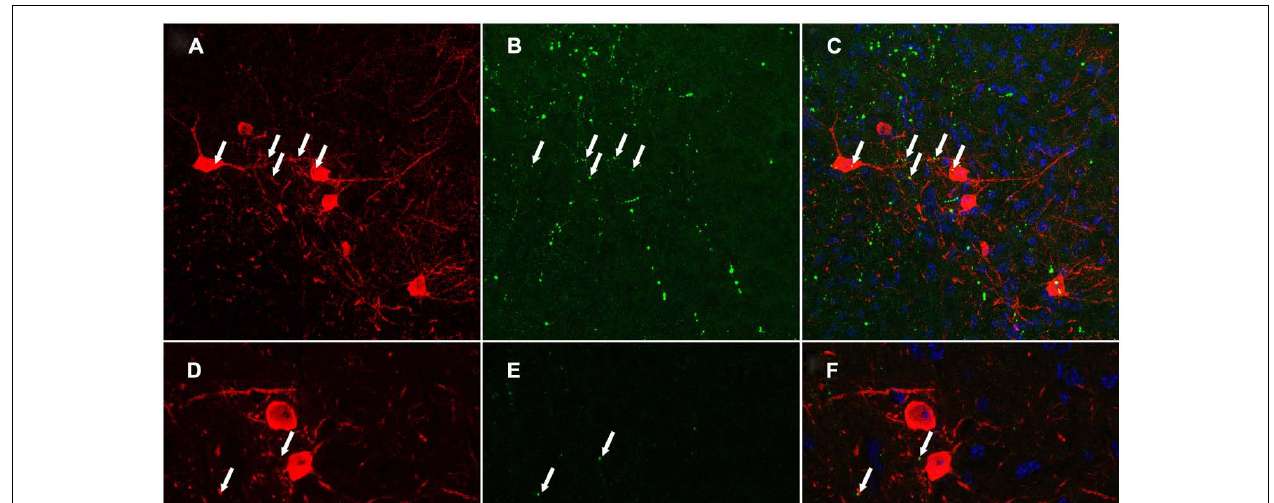
corticospinal terminations are found on motor neuron cell bodies, while sparse EGFP + puncta are detected on ChAT + presumptive dendrites (arrows). Note larger size of some EGFP + dots likely due to tyramide mediated signal amplification. Scale bar: (A – C) 75 μ m; (D – F) 30 μ m.